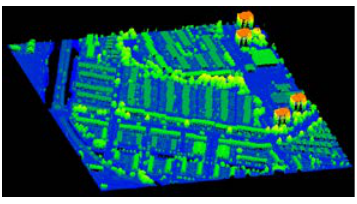
Figure 7. AHN-3 Testing sample